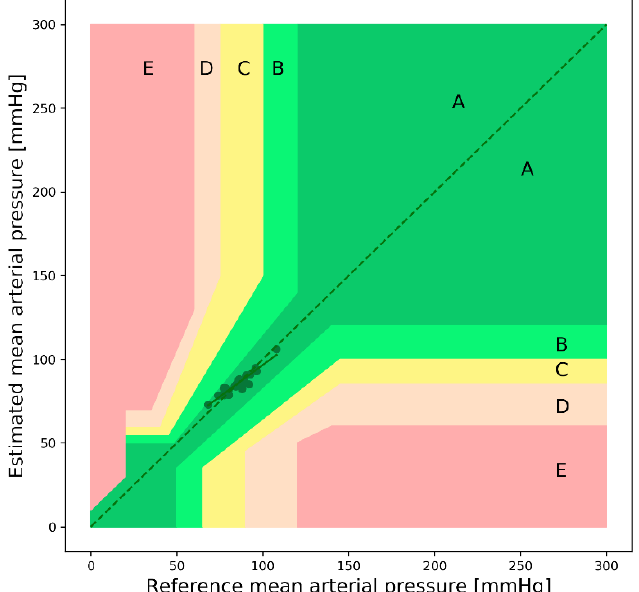
Figure 20. Error grid analysis plot of the MAP (self-made dataset). Table 11. Evaluation metrics for SBP, DBP, and MAP.